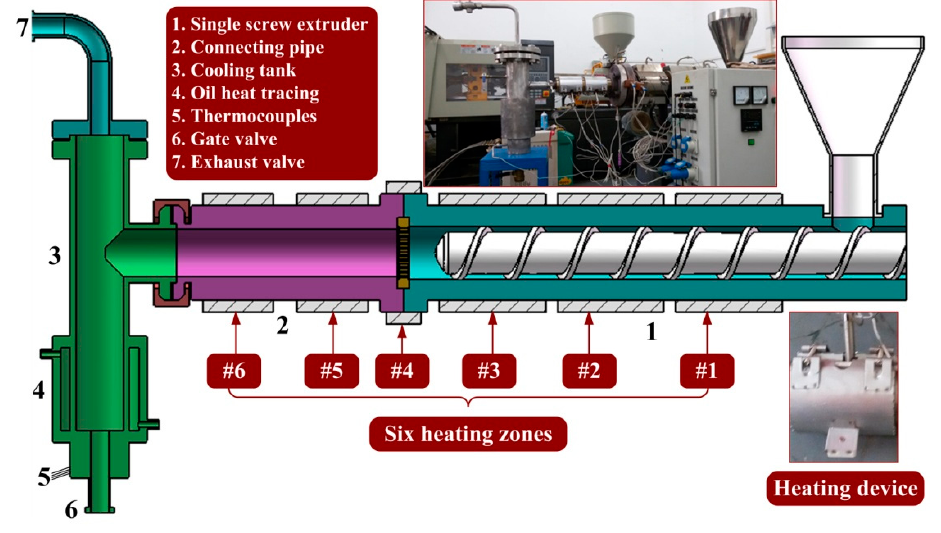
Figure 1. Flowchart of test platform.